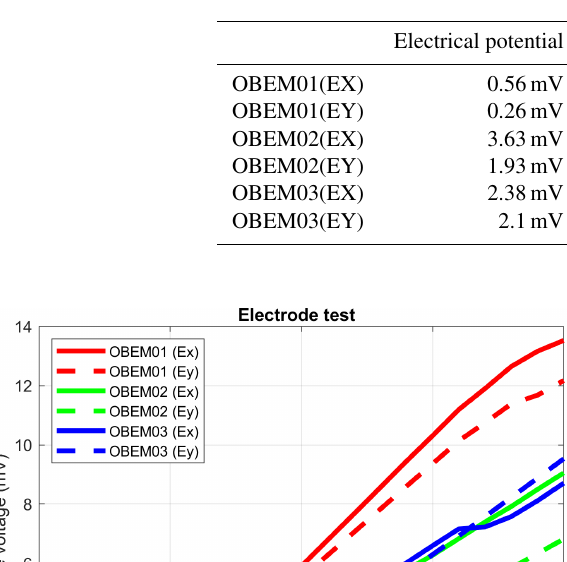
Table 3. The self-potential, impedance and induced voltage results for each pair of silver chloride electrodes.